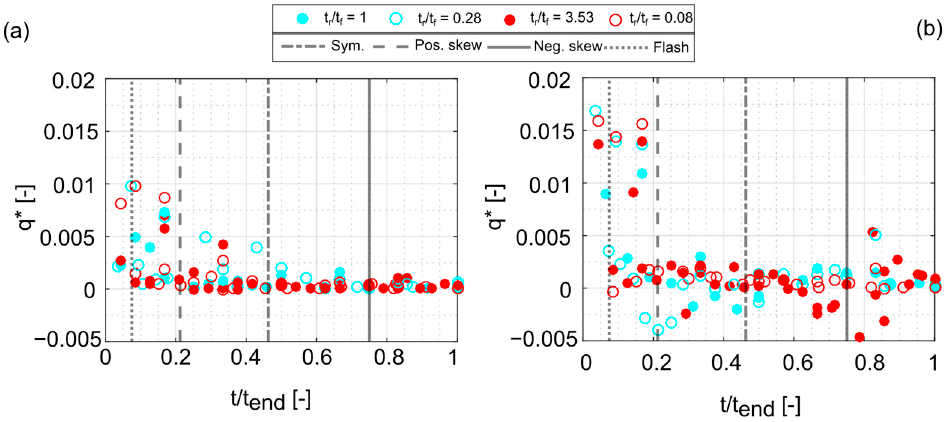
Figure 12. Dimensionless bedload (q*) versus dimensionless time scale of experiments (t/t end ): ( a ) clear water and ( b ) general sediment transport.